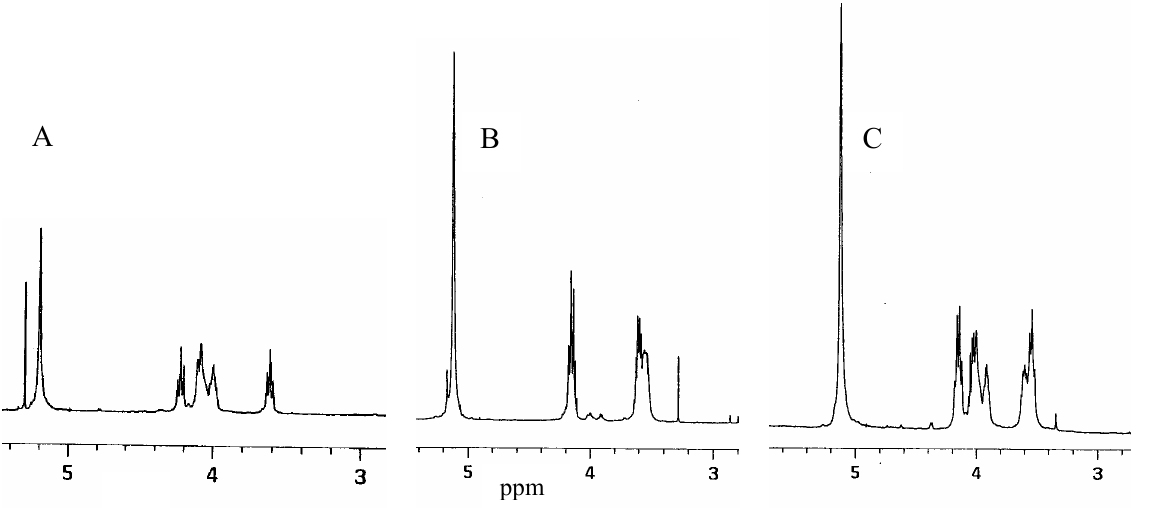
Figure 4 . Expanded 500 MHz 1 H-NMR spectra of indoline 6a (A), quinoline 7a (B) and an unpurified sample of 6a and 7a